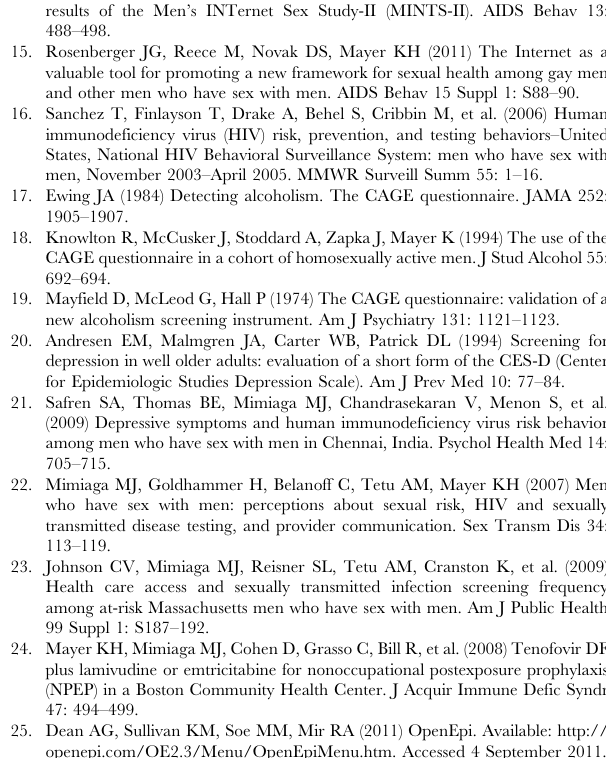
Post-exposure Prophylaxis (PEP) Aware of